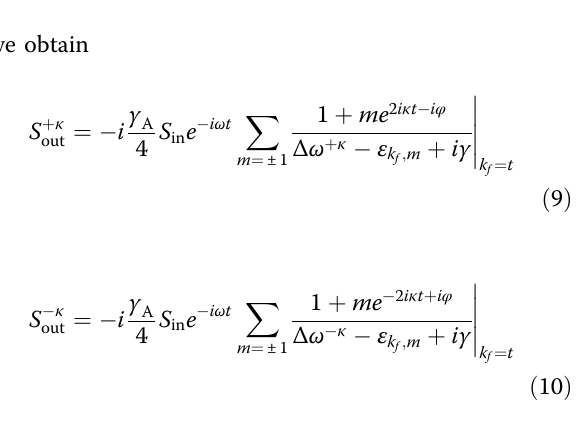
Fig. 3 Projected band structures under condition of V 1 < V 2 . Experimentally observed projected band structures with modulation amplitudes a V 1 = 1 V, V 2 = 3 V, and b V 1 = 0 V, V 2 = 3 V. Red and blue arrows indicate the chosen bands to apply the Zak phase extraction method. Projected band structures from simulations under coupling strengths c g 1 = 0.02 Ω , g 2 = 0.06 Ω , and d g 1 = 0, g 2 = 0.06 Ω , with ϕ 1 = ϕ 2 =